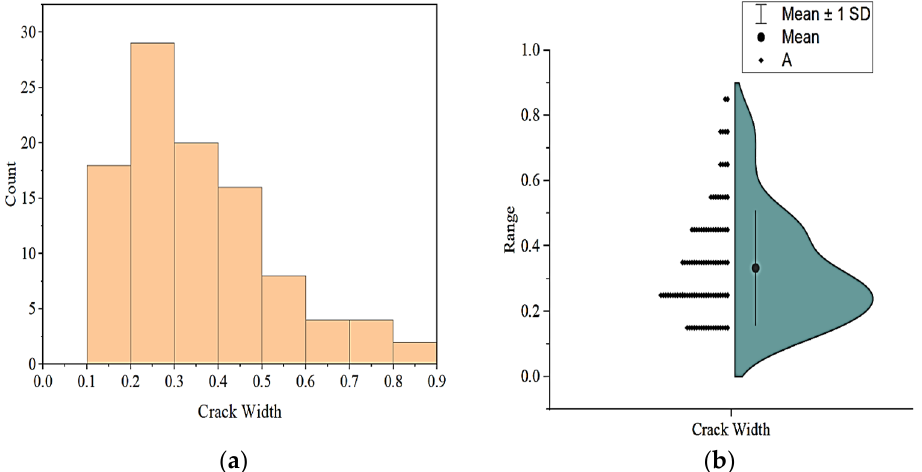
Figure 16 . Output parameter crack width: ( a ) histogram and ( b ) half violin diagram. Figure 16. Output parameter crack width: ( a ) histogram and ( b ) half violin Table 13. Statistics of top three artificial neural networks combined Grey Wolf Optimizer on training and testing data.